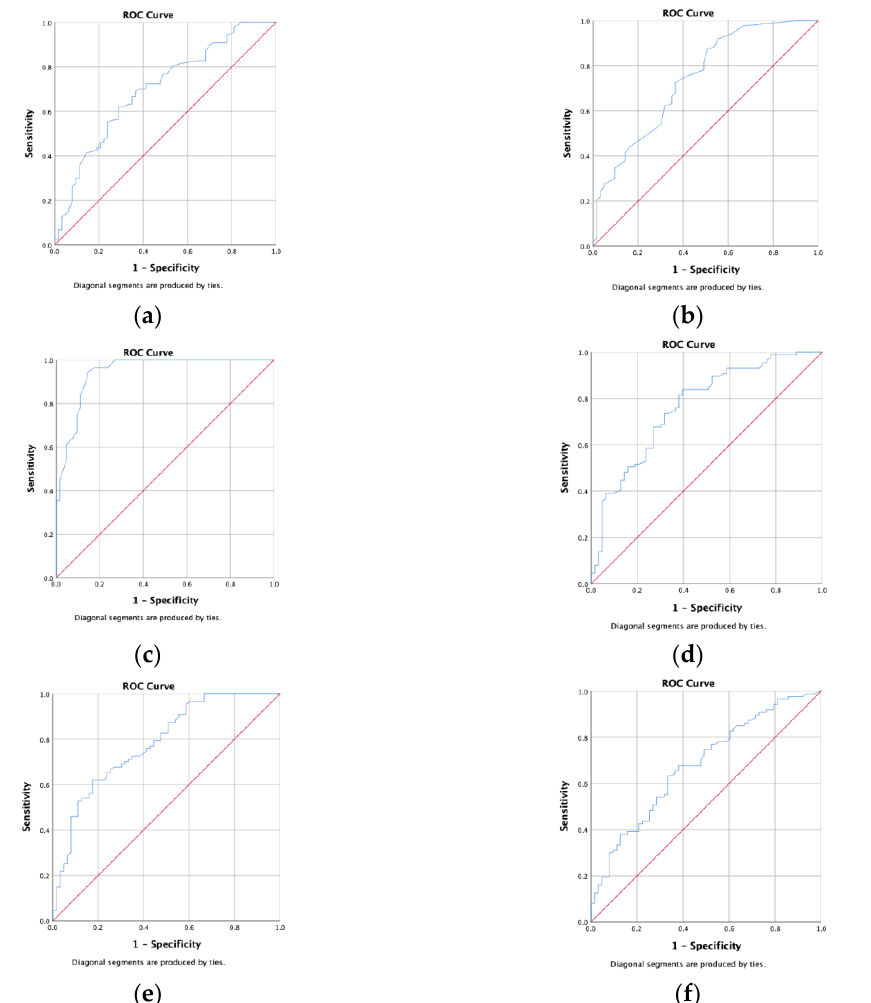
Figure 2. Receiver operating characteristic curves of the anthropometric indices. (a) BMI; (b) BWH; (c) WC; (d) BFM; ( e ) BFP (f) BMR Table 6. Area under the curve (AUC) and cutoff values of anthropometric indices to estimate in- sulin resistance between obese children and adolescents.